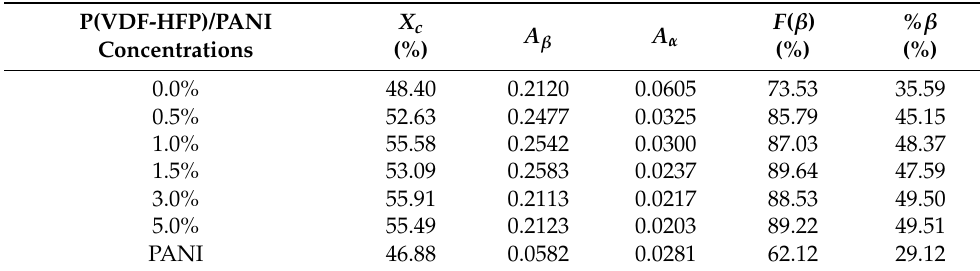
Table 2. Evaluated crystallinity and β -phase fraction in the